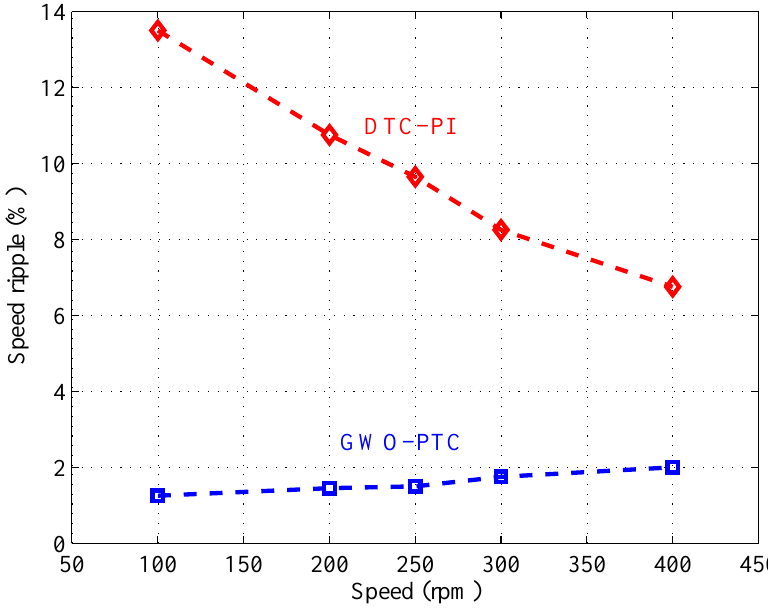
Figure 14. Evolution of the SRF at different